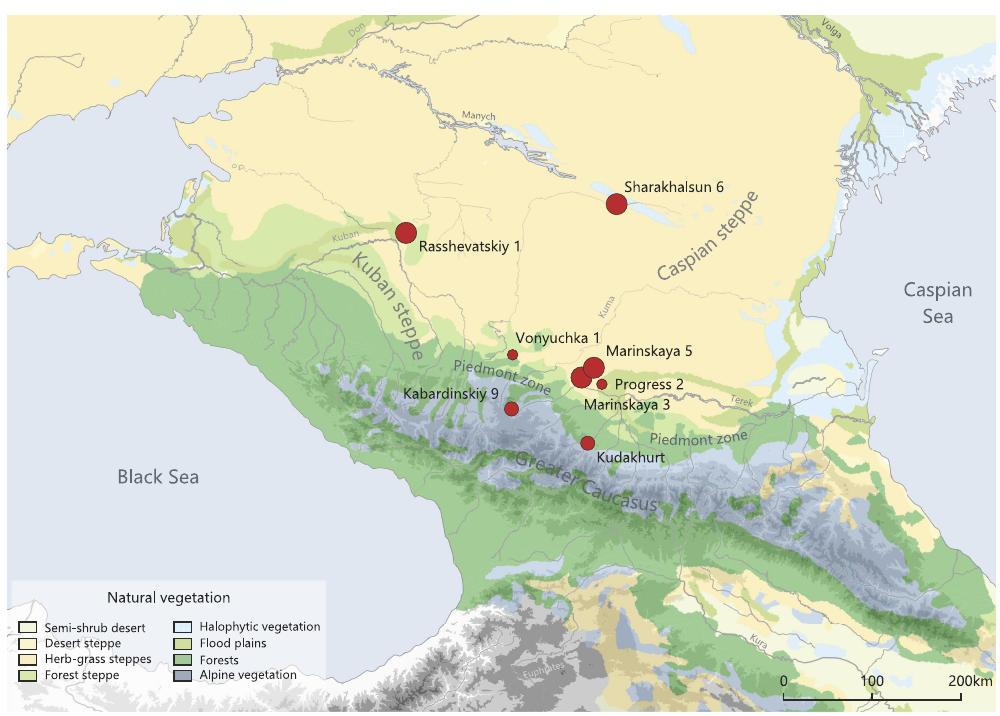
Fig 1. Map showing major landscapes, vegetation zones and investigated sites in the North Caucasus region. The symbol sizes for the sites reflect the number of samples investigated. Background map after {Stone, 2003 #9972}. This dataset is openly shared, without restriction, in accordance with the NASA Data and Information